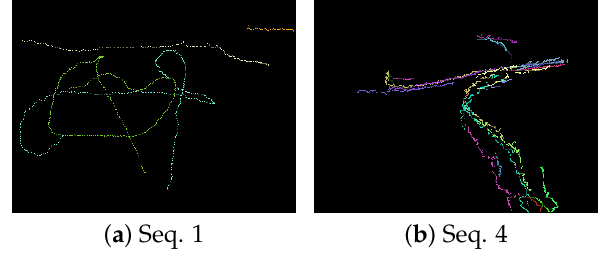
Figure 11. The trajectory estimate